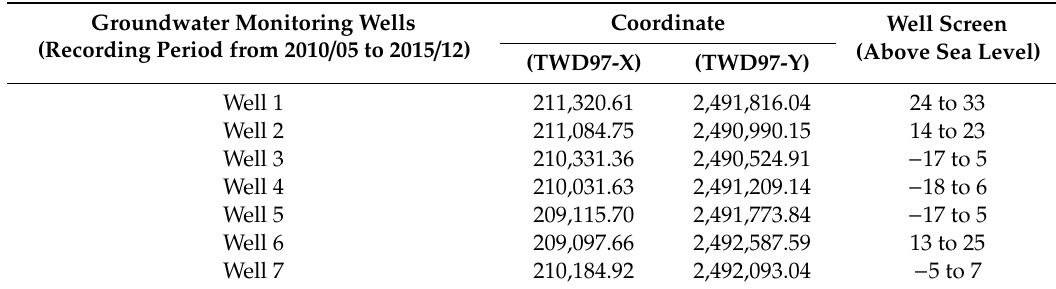
Figure 2. Location map of the study area (W1 to W7 is Well 1 to Well 7, respectively).